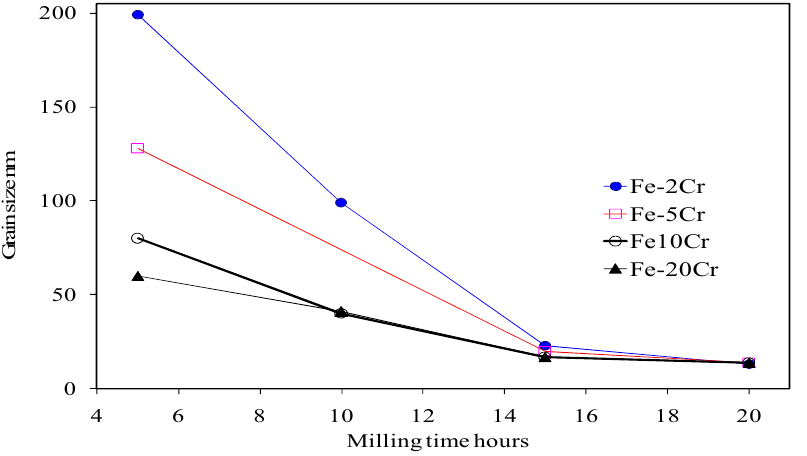
Figure 1. Decrease in the crystallite grain size with increasing duration of milling of elemental powders into Fe-Cr alloy powders with different Cr contents [21].